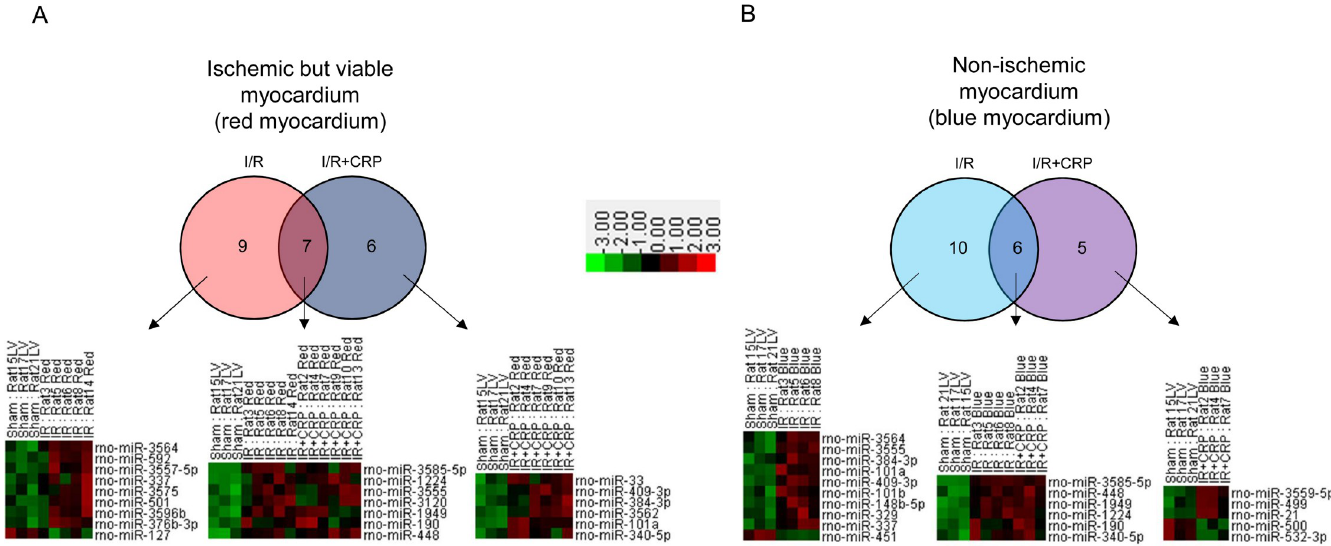
Fig 4. miRNA expression profiles. Global miRNA expression analysis of ischemic but viable myocardium (A, red myocardium by Evans blue and TTC staining) and non-ischemic myocardium (B, blue myocardium by Evans blue and TTC staining). Venn diagrams (upper) and corresponding heat maps (lower) show significantly different expressions of miRNAs when compared to sham group. miRNAs with average expression count > 10, fold change > 2 or < -2, and P value < .05 were selected.